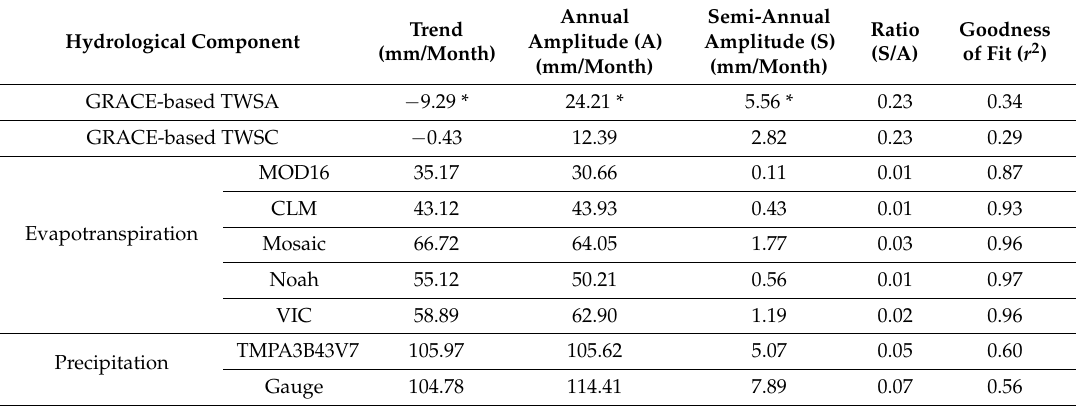
Table 5. Trends, and annual and semi-annual amplitudes of hydrological components from January